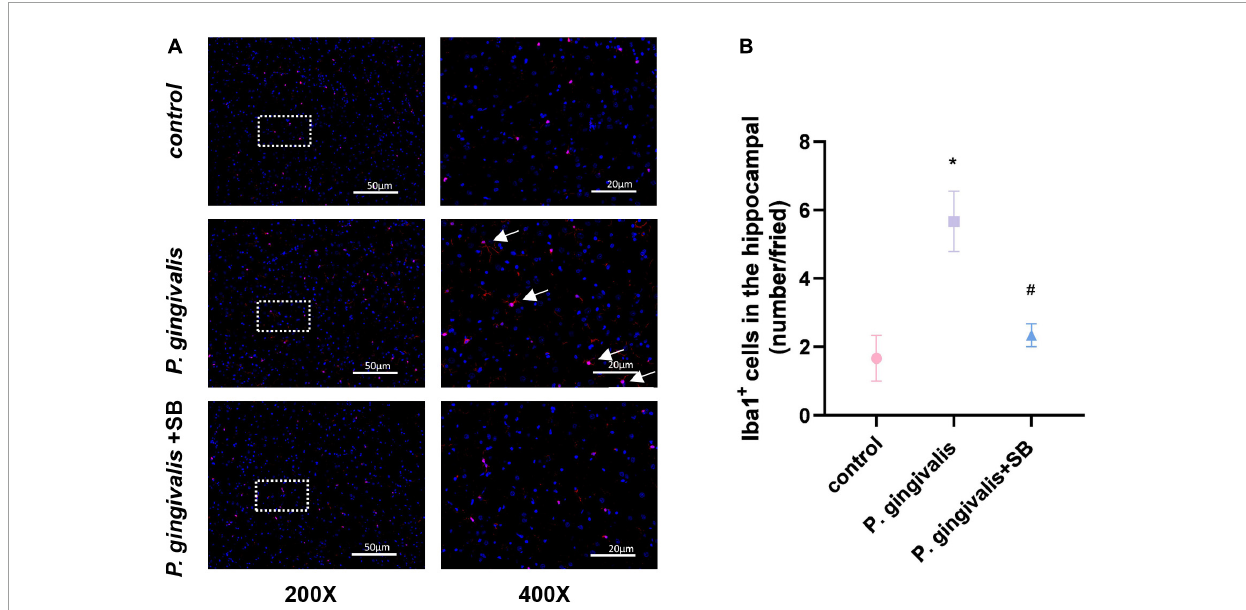
FIGURE9 Effects of periodontitis on microglia in the hippocampus. Histopathological analysis of brain sections was performed using immunofluorescence. (A) Microglia were visualized with Iba1 (red). White arrows indicate activated microglia. Quantification of Iba1 levels in the hippocampus is shown. (B) Iba1-positive cells in the hippocampus (number/field). Experimental values are expressed as the mean ± SEM ( n = 3 per group) (200 × and 400 × , bar = 50 and 20 µ m). * p < 0.05 compared with the control group, # p < 0.05 compared with the P. gingivalis